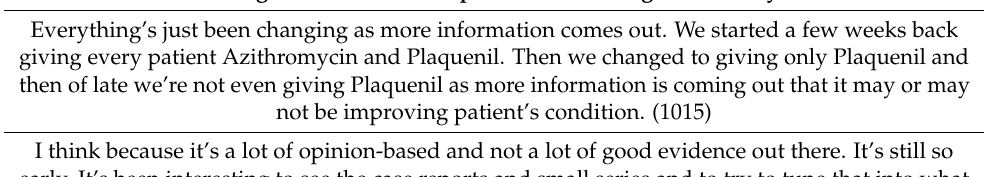
Table 3. Cont. Some recognized the iterative process of learning in health